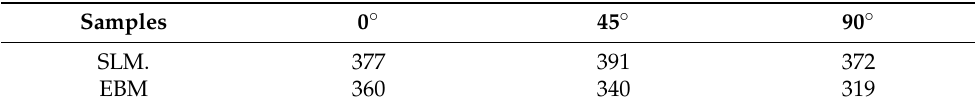
Table 2. Average hardness (HV300) for AM samples *.